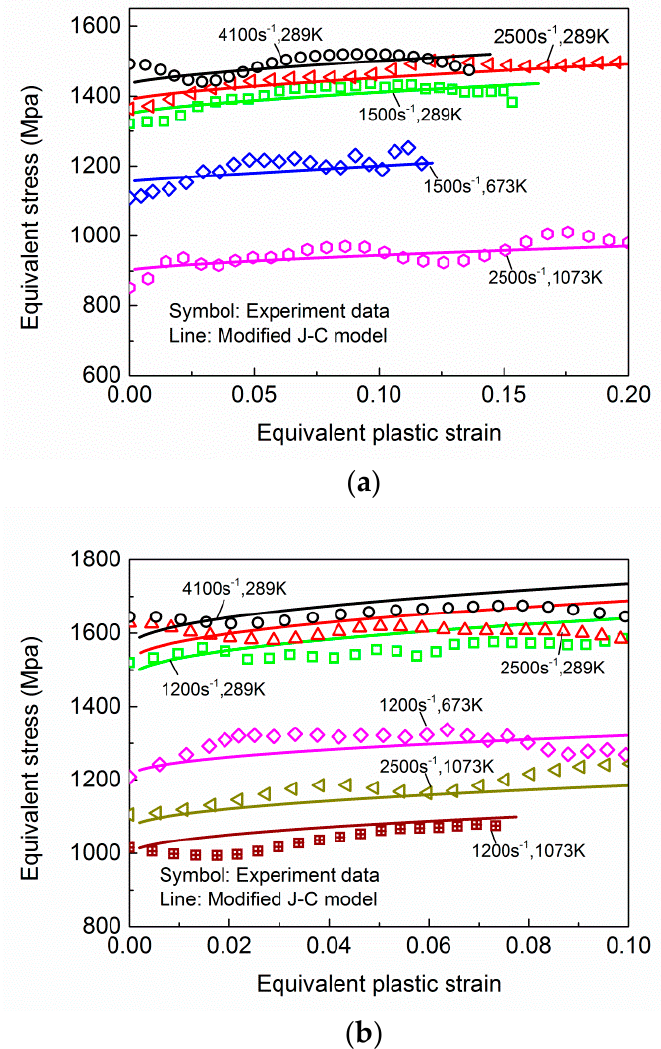
Figure 15. Accuracy validation of modified J-C constitutive: ( a ) TC-4; ( b ) AM-P-TC-4.